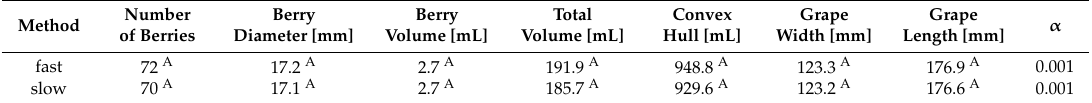
Table 1. Comparison between fast (0.5 s − 1 ) and slow (0.16 s − 1 ) scanning method. p -values from the One-way-ANOVA results for the 3D-BT estimated traits number of berries, berry diameter, berry volume, total volume convex hull volume (Convex Hull), grape width and grape length. Different letters indicate significant